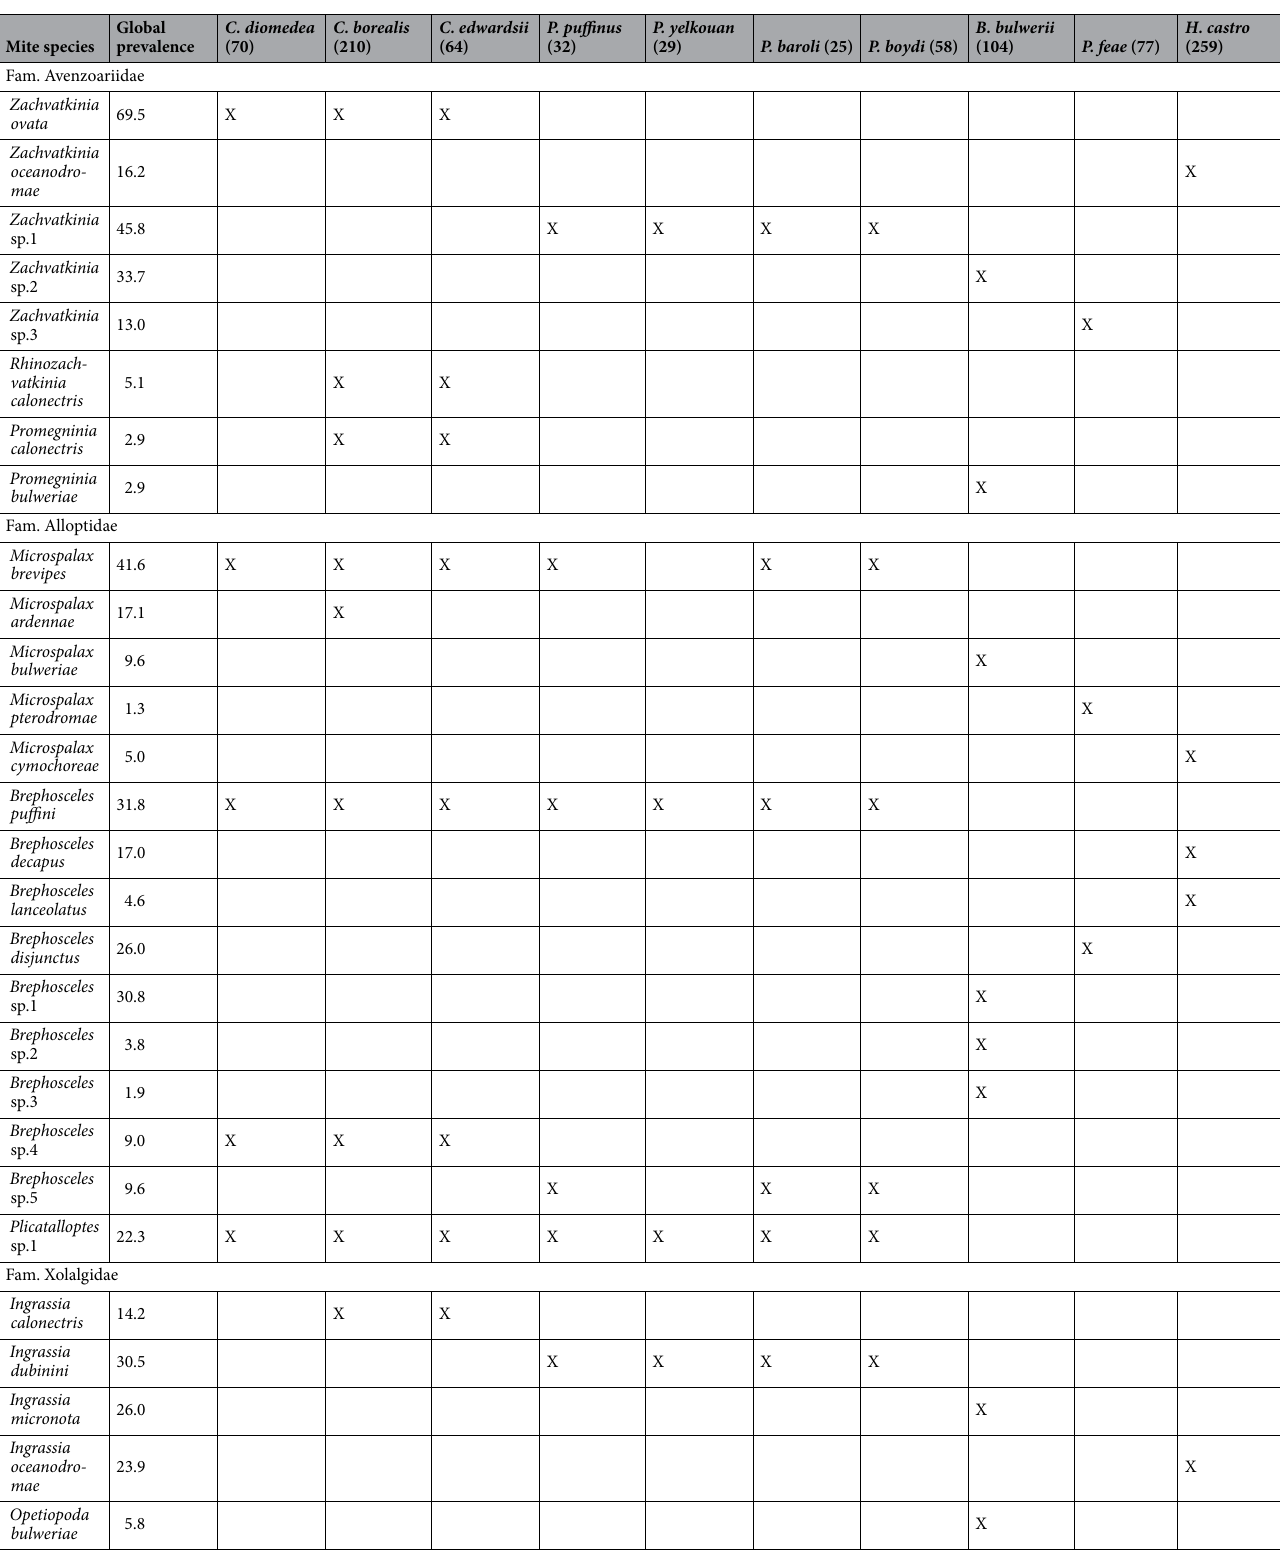
Table 2. Feather mite species found on procellariform seabirds breeding in the north-east Atlantic Ocean and Mediterranean Sea and their global prevalence. Band-rumped storm-petrel Hydrobates pelagicus was not included in this analysis. The sample size of each host species is indicated below its corresponding